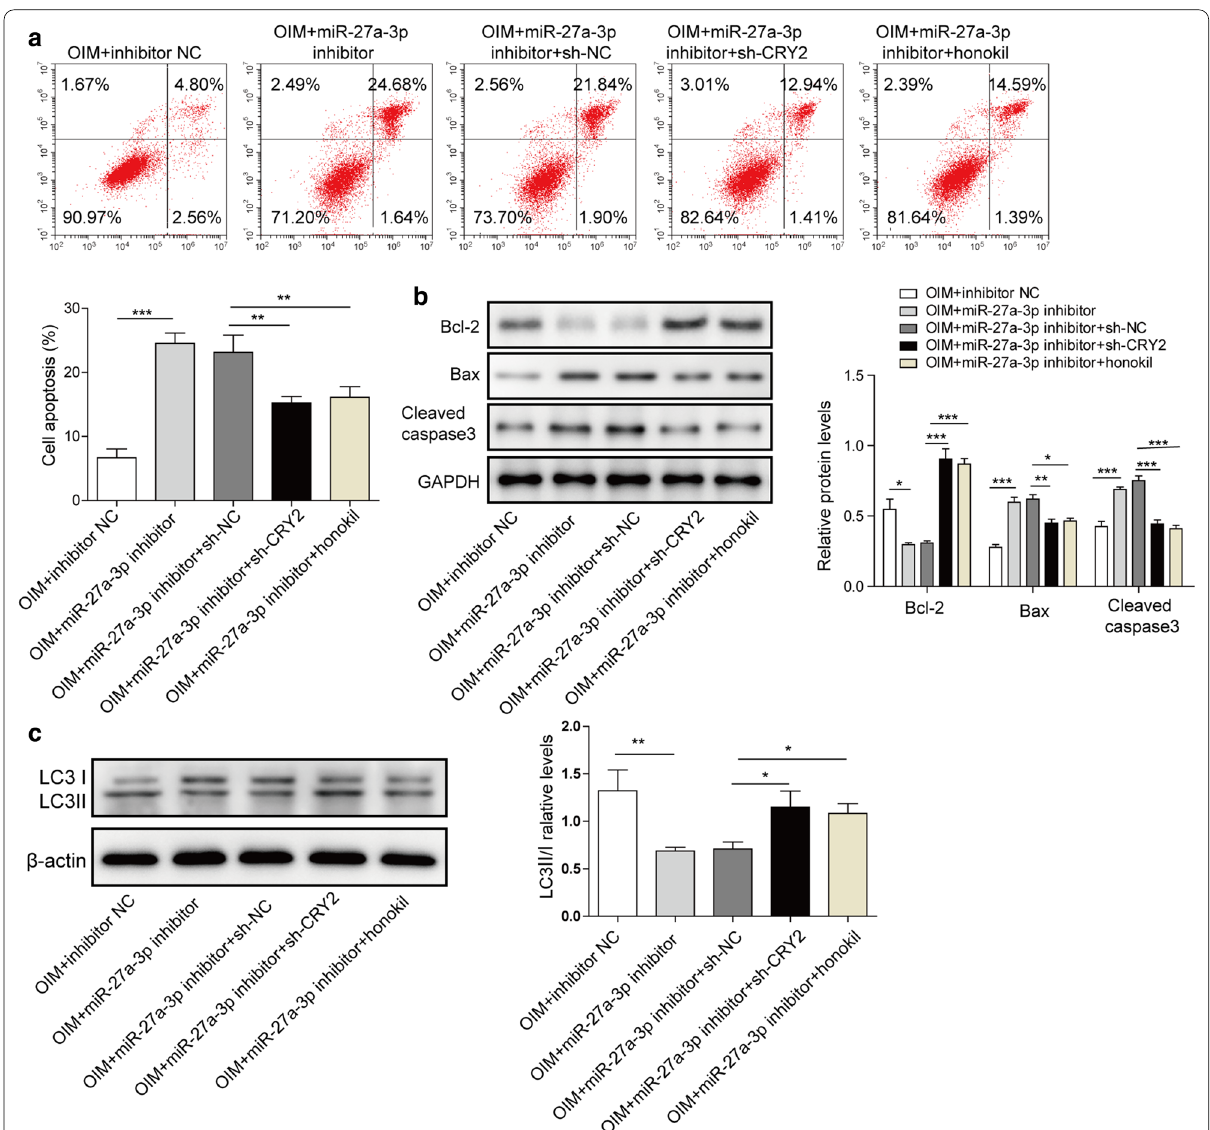
Fig. 5 CRY2 knockdown could reverse the effect of miR‑27a‑3p inhibitor on cell apoptosis and autophagy. Cells were treated with miR‑27a‑3p inhibitor, miR‑27a‑3p inhibitor CRY2 shRNA or miR‑27a‑3p inhibitor honokiol. a The apoptosis of cells was tested by flow cytometry. b The + + protein expressions of Bax, Bcl‑2 and cleaved caspase 3 were detected by western blotting. c The protein expressions of LC3 I and LC3 II were detected by western blotting. *P < 0.05, **P < 0.01, ***P <